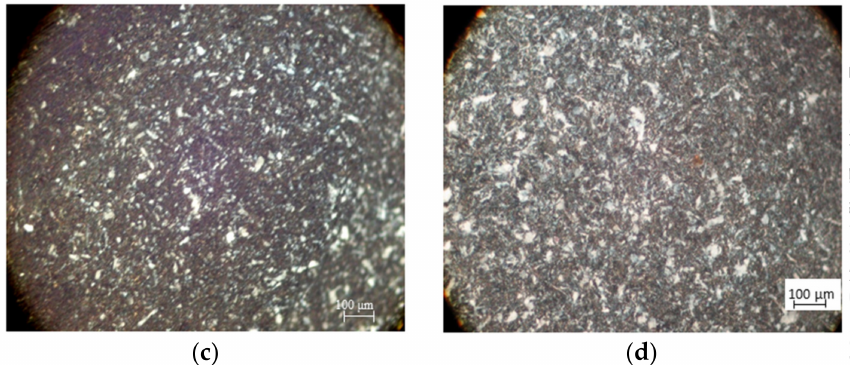
Figure 2. Optical microscopy image of sandblasted surface using T–ZrO 2 particles (( a ) 4 atm; ( b ) 6 atm) and C–ZrO 2 (( c ) 4 atm; ( d ) 6 atm) × 200.